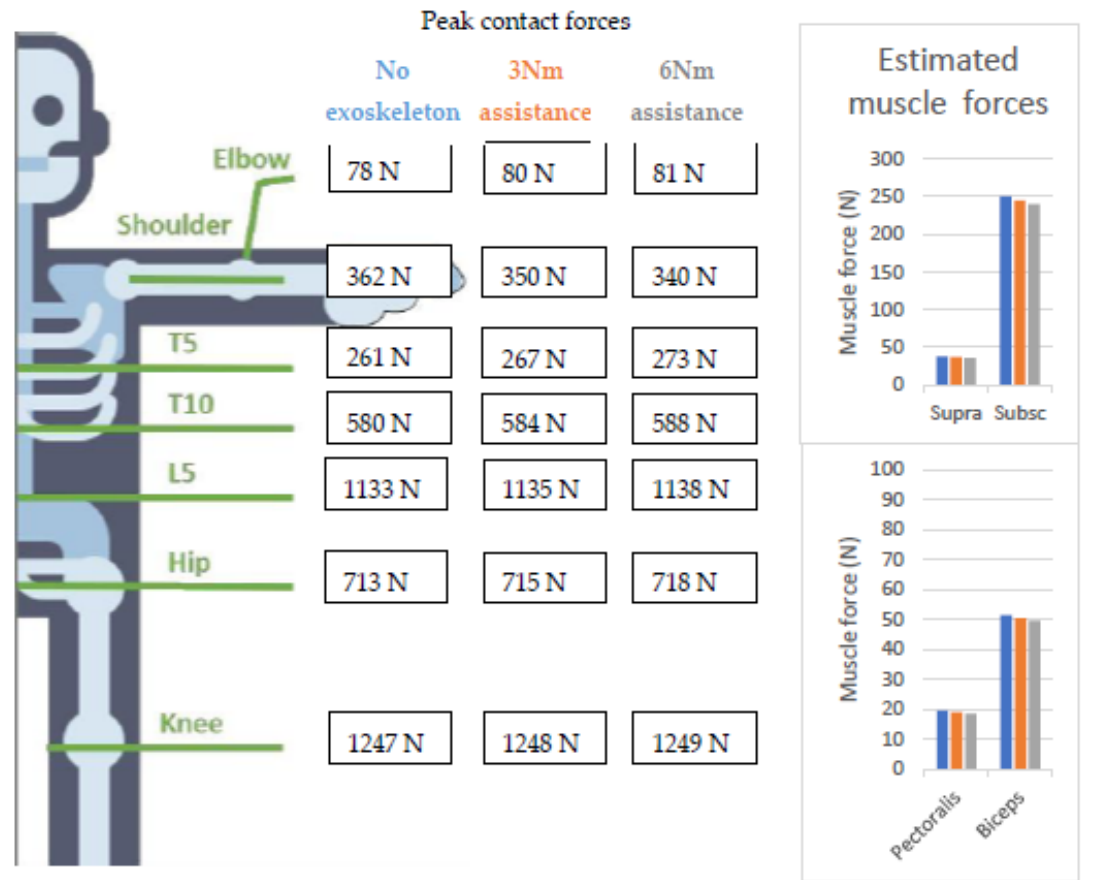
Figure 6. Peak joint contact forces in the different joints calculated with the musculoskeletal-modeling workflow and compared with the different tissue-specific injury thresholds implemented in the MATE for the shoulder exoskeletons. The probability of failure is not shown as it was equal to 0%, indicating this task has a low risk of developing low back pain. In addition, muscle groups at risk are not shown as the exoskeleton did not affect this number. However, estimated muscle forces of the m. Supraspinatus (Supra), m. Subscapularis (Subsc), m. Pectoralis major (Pectoralis), and the m. Biceps brachii (Biceps) did decrease with increasing the exoskeleton assistance.